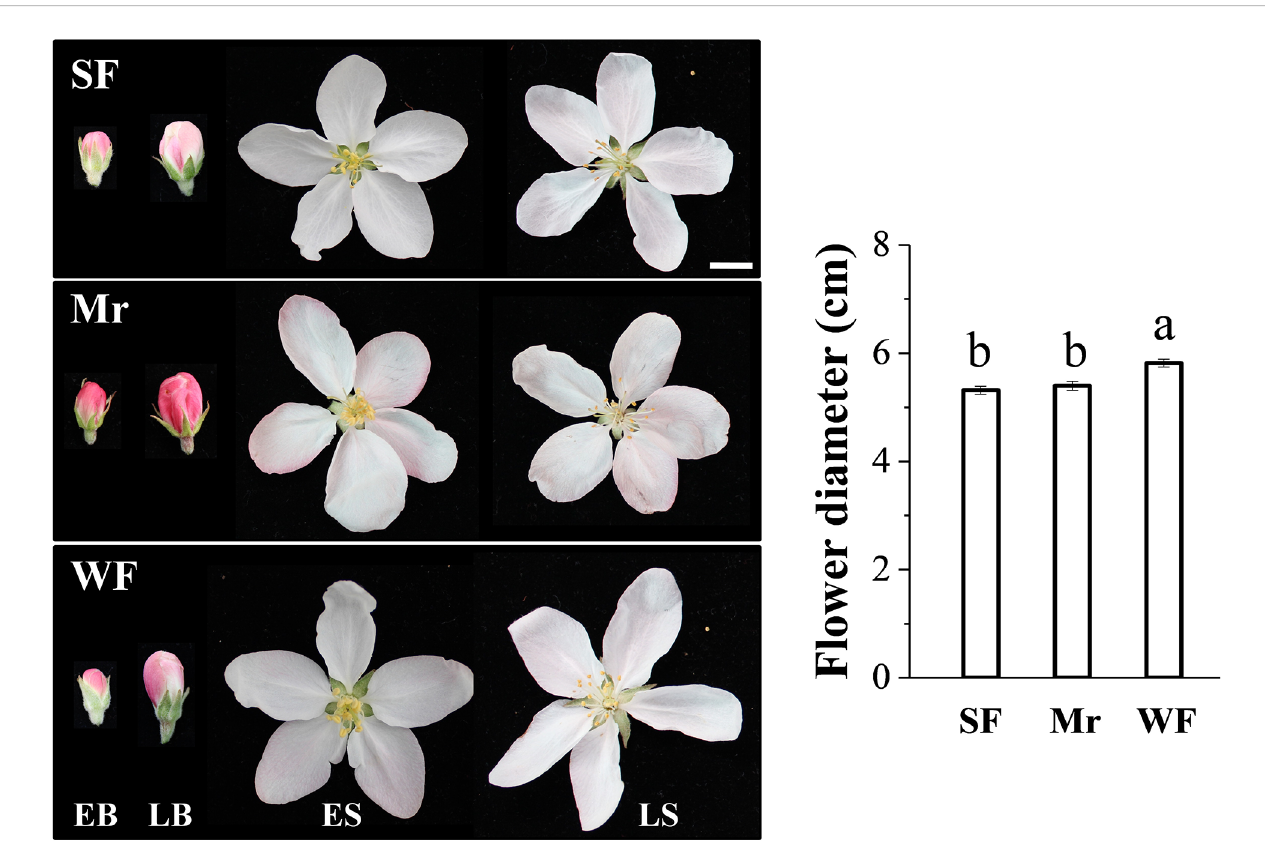
FIGURE 1 Flower phenotypes at four developmental stages in the Malus robusta materials. EB, early balloon stage; LB, late balloon stage; ES, early fl owering stage; LS, late fl owering stage; Mr, standard M. robusta ; SF, strongly fragrant progeny; WF, weakly fragrant progeny. The histogram shows the fl ower diameter of each material at the LS stage. Different lowercase letters indicate a signi fi cant difference using one-way ANOVA followed by Tukey ’ s test ( P < 0.05). Scale bars = 10.0